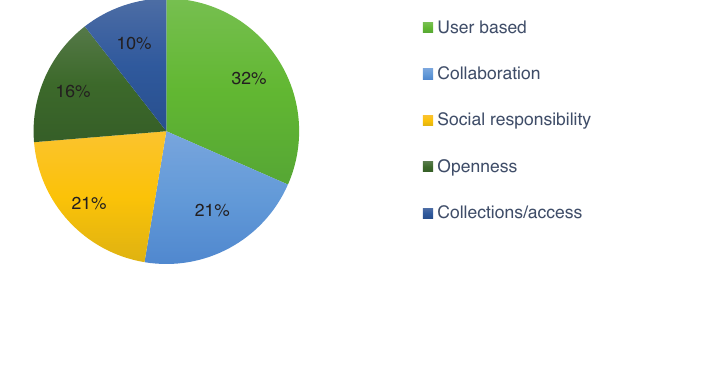
Fig. 4: Values from the strategies that were challenged during the